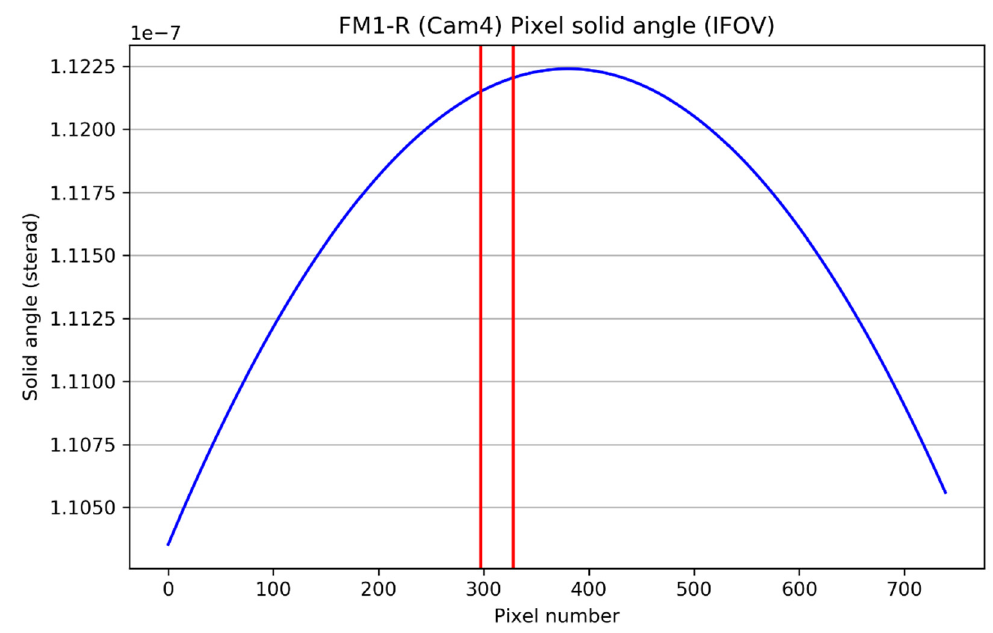
Figure 10. Variation of pixel IFOV along CCD. In observation performed in June 2018, the moon was imaged by pixels between red lines marked on the chart.